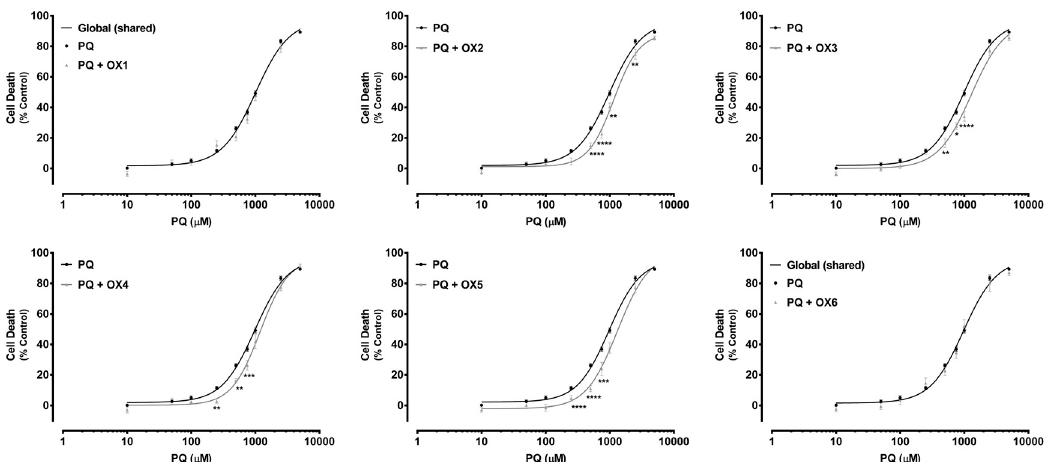
Figure 6. Paraquat (PQ) concentration—response (cell death) curves obtained in the absence (PQ curve) or in the presence of the six tested oxygenated xanthones (20.0 µ M) (PQ + OX 1–6 curves). Results are presented as mean ± SEM from four independent experiments (performed in triplicate).